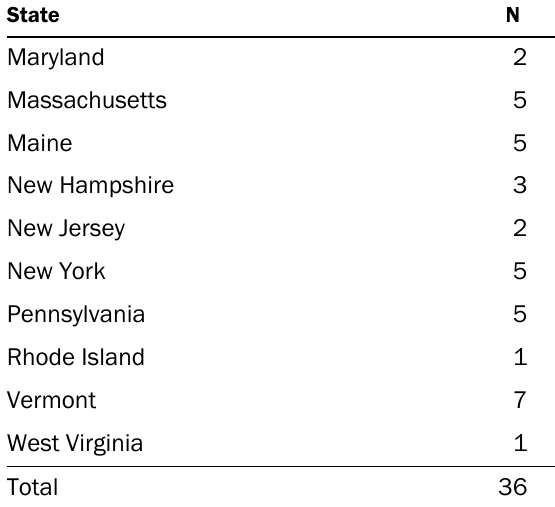
Table 3. Interviews by State